Question: What visual encoding does this figure use to show its data?
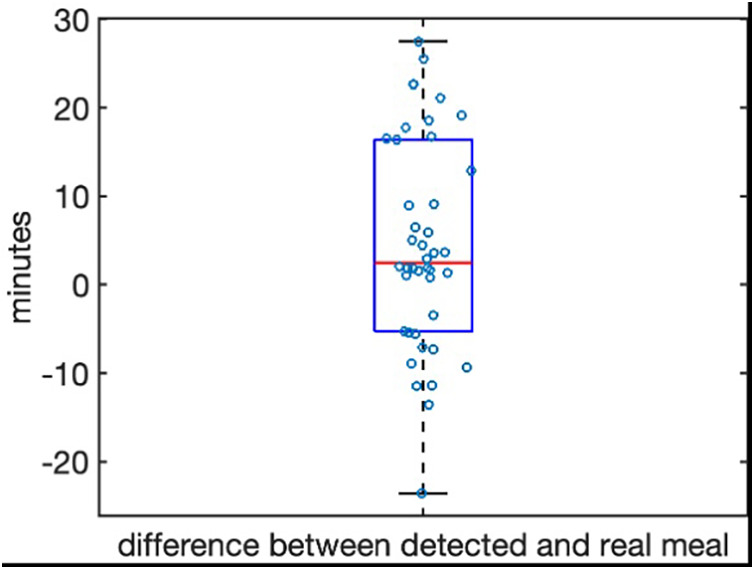
Answer: box